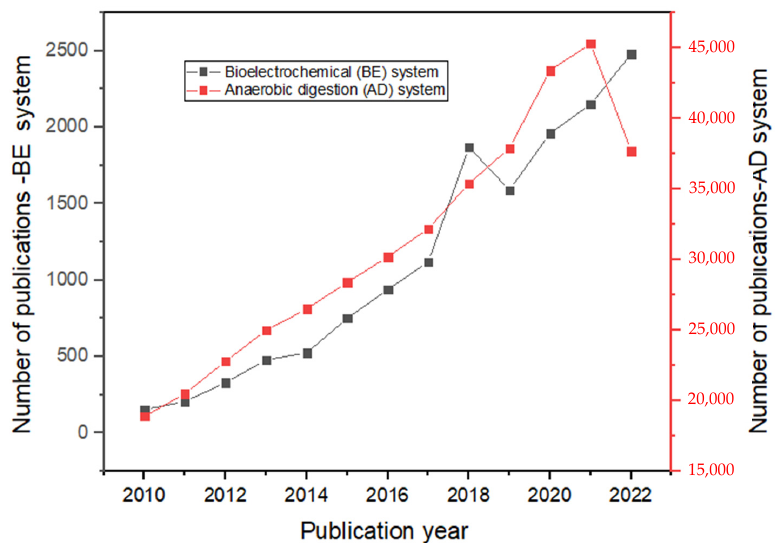
Figure 1. Google scholar publication trend of bioelectrochemical and anaerobic digestion systems from 2010–2022.